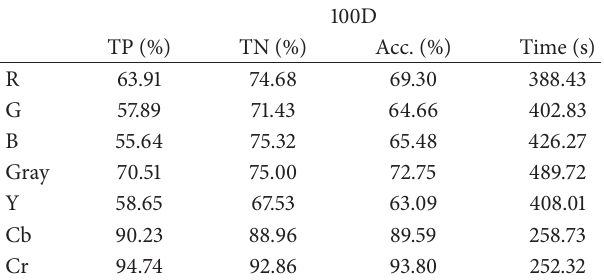
Table 1: Detection accuracy and computational time for RLRN with